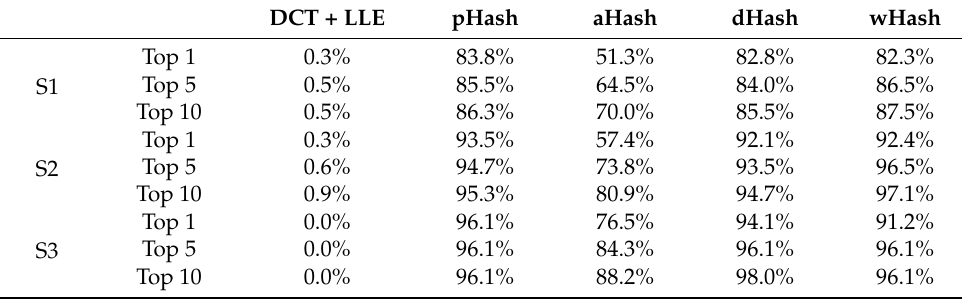
Table A10. Correct matches results for database vs. TS2 comparison—1024